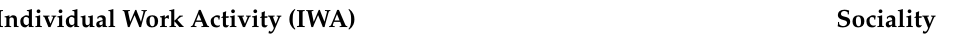
Table 1. Classification of example individual work activities (IWAs). See Supplementary Materials for a complete